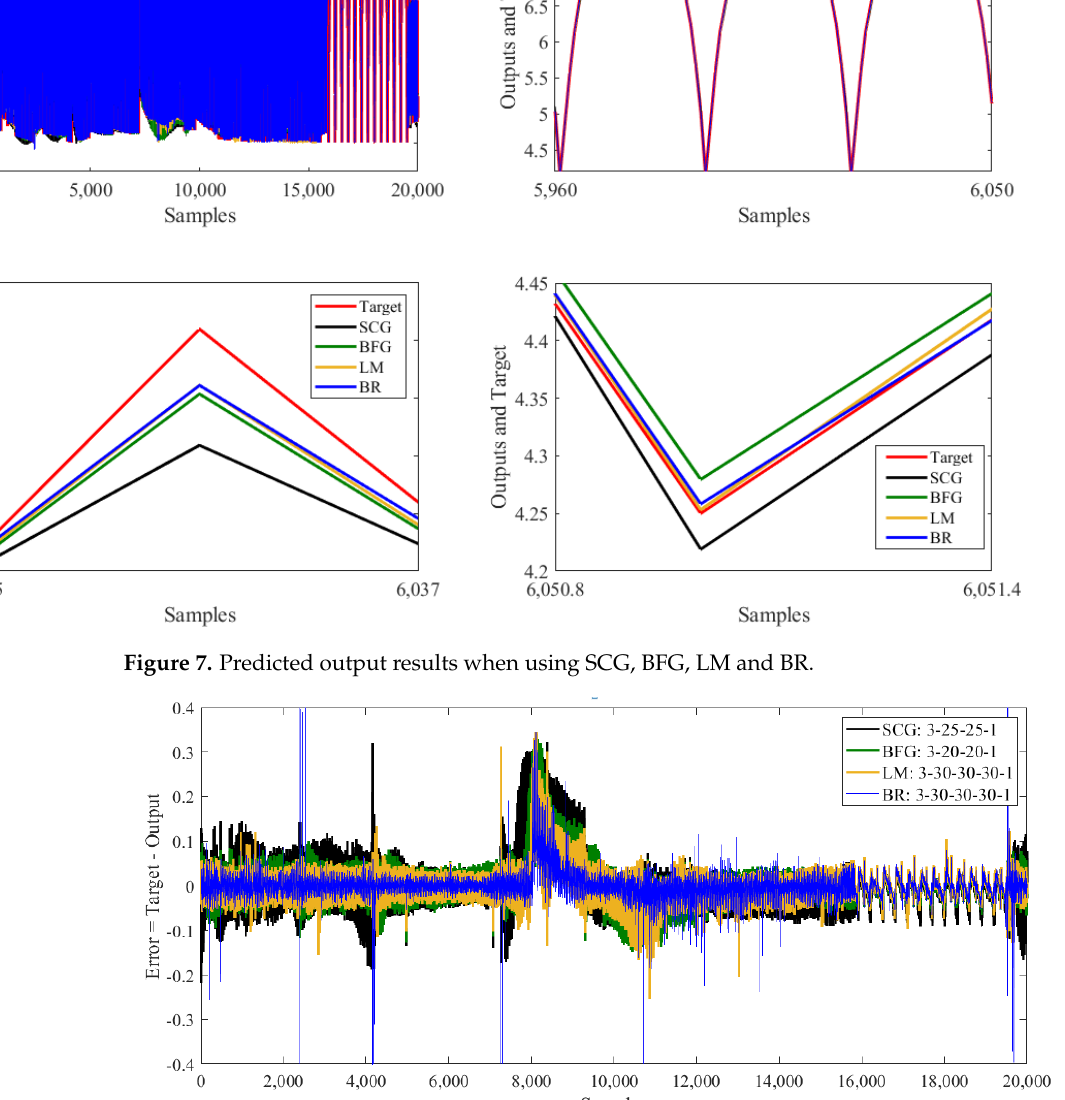
Figure 8. Obtained training errors when using SCG, BFG, LM and